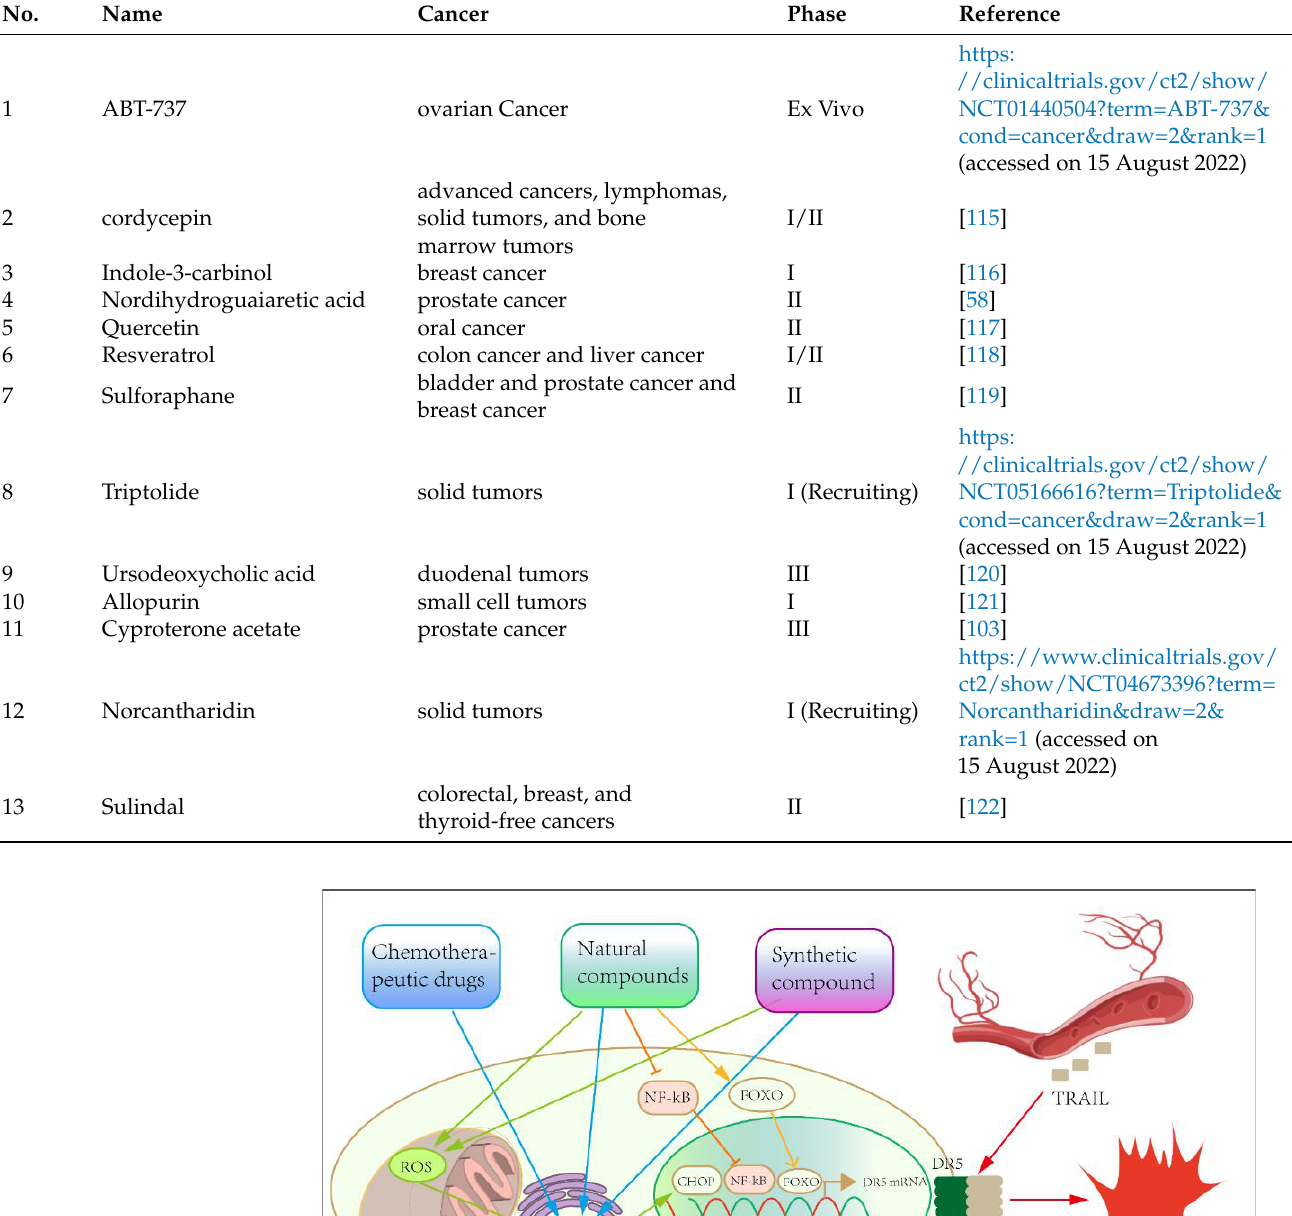
Table 4. The small molecule compounds in this paper that have been tested in anti-tumor clinical trials.